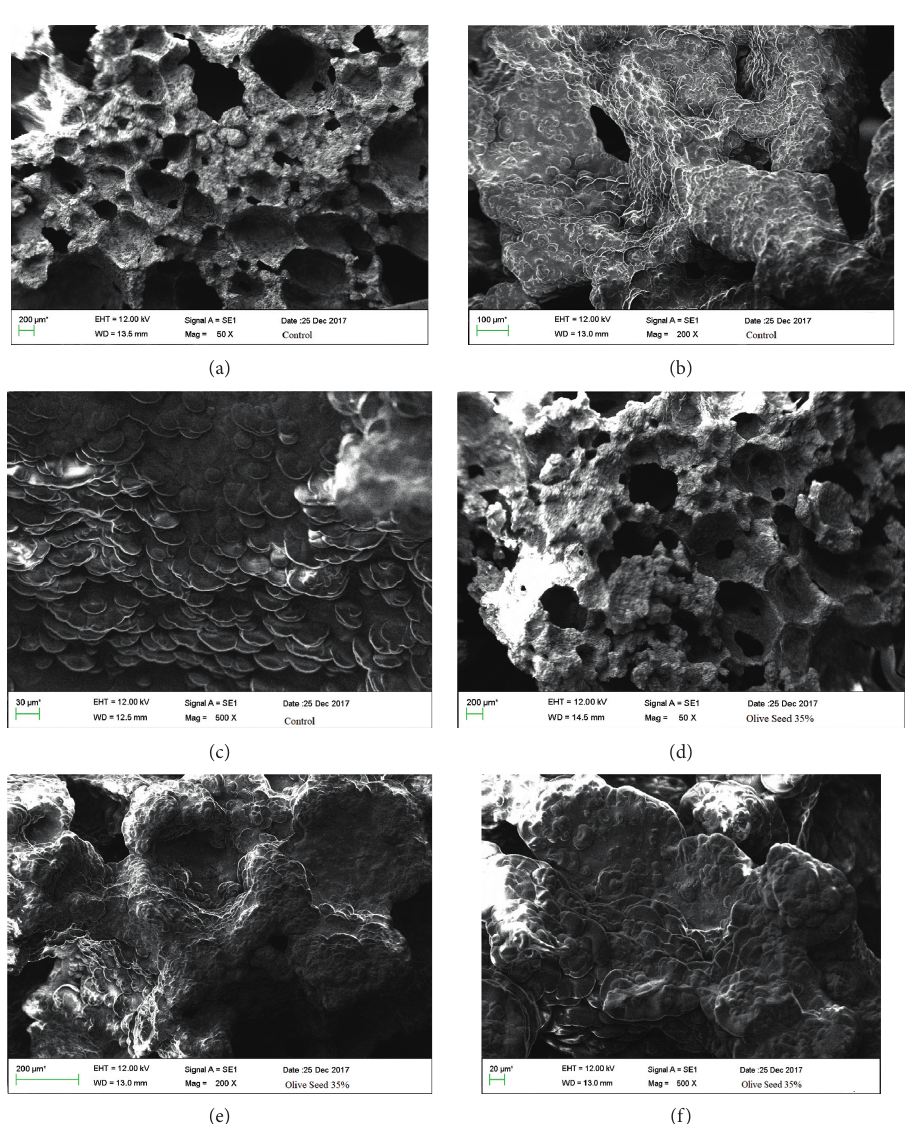
Figure 2: SEM images of sponge cakes containing 0% (control) (a, b, c) and 35% OSP (d, e, f) with different